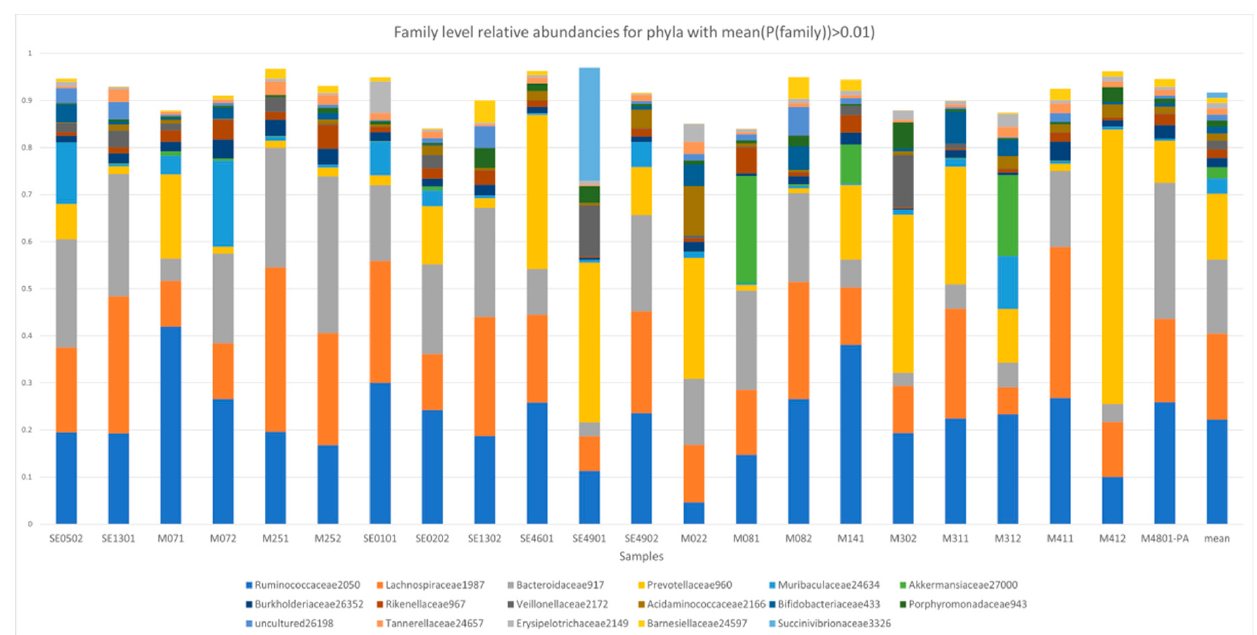
Figure 15. The relative abundances of bacteria at the family level between the two groups. The first 6 columns are the subjects of the OSA − atherosclerosis group, and the next 16 columns are the subjects of the OSA + atherosclerosis group.